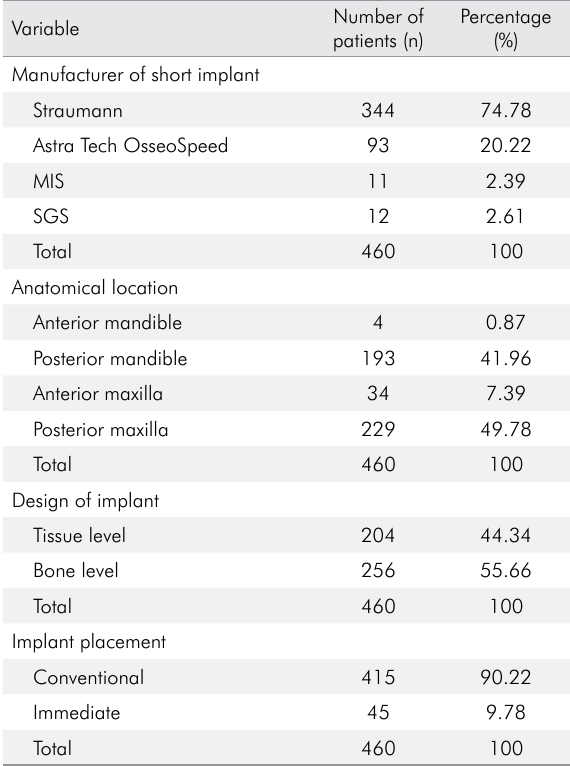
Table 3. Frequency distribution of different variables in relation to short